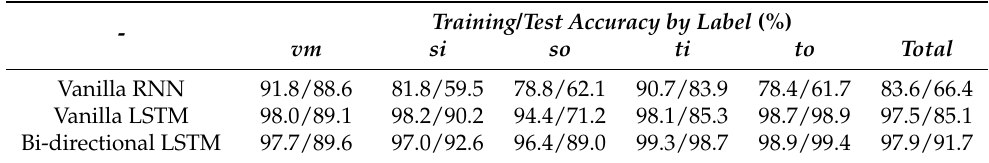
Table 3. Comparison of training and test accuracy of RNN and LSTM and bi-directional LSTM model for the 5 different hand-guiding gesture classifications.